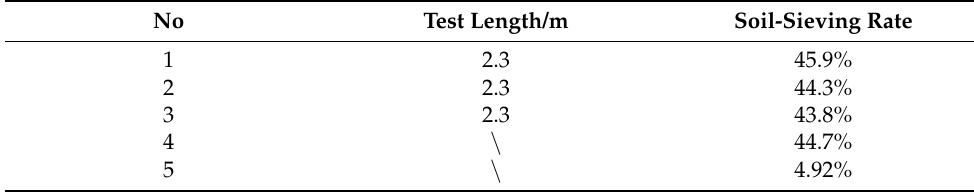
Table 6. Measurement results of the field